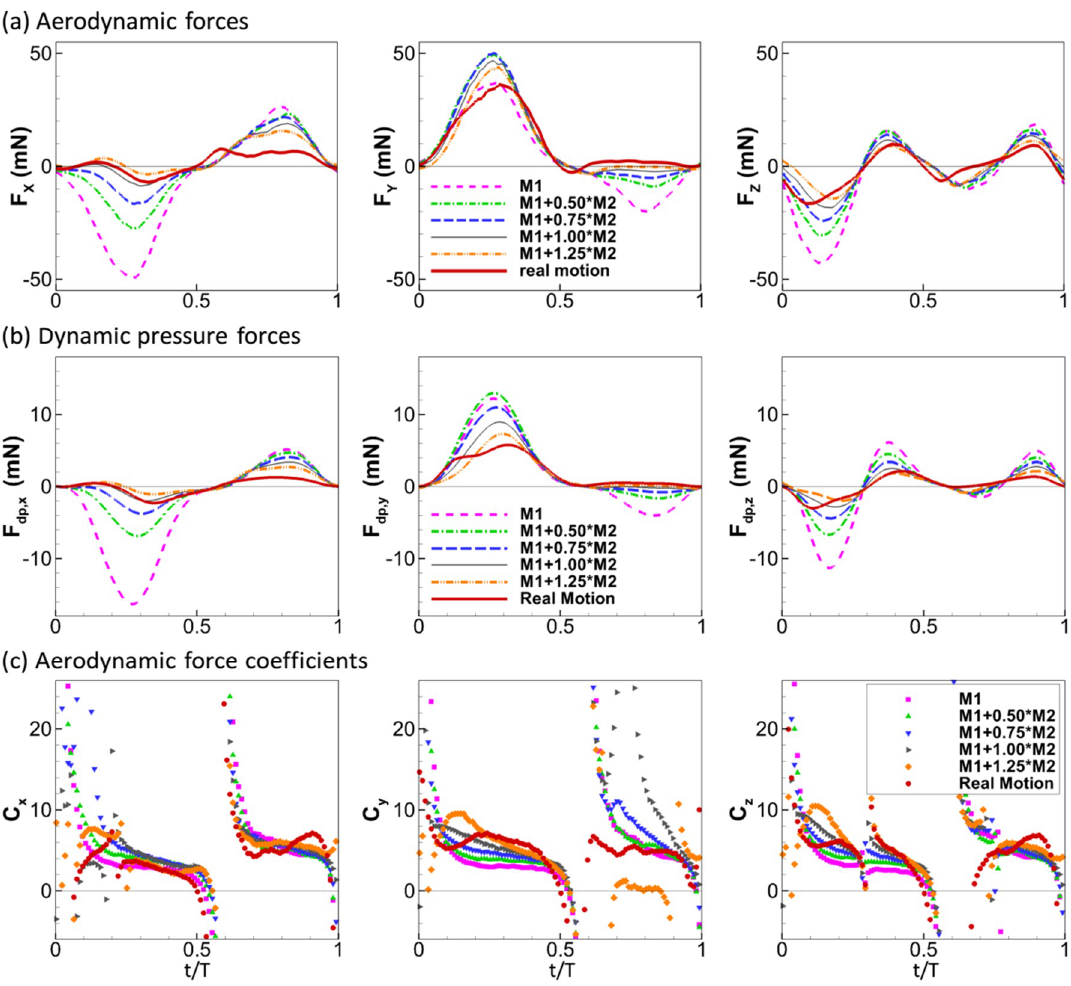
Figure 8. Aerodynamic forces ( a ), dynamic pressure forces ( b ) and aerodynamic force coefficients ( c ) in the three directions.